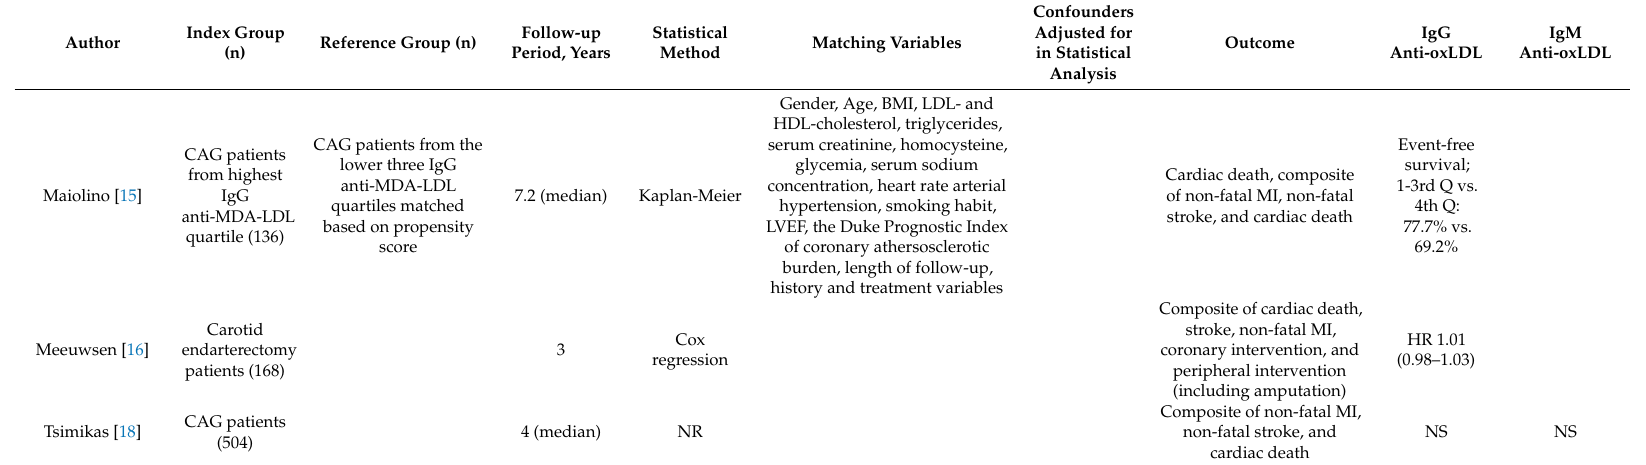
Table 4. Anti-oxLDL antibodies and cardiac endpoints in subjects undergoing clinically indicated coronary angiography